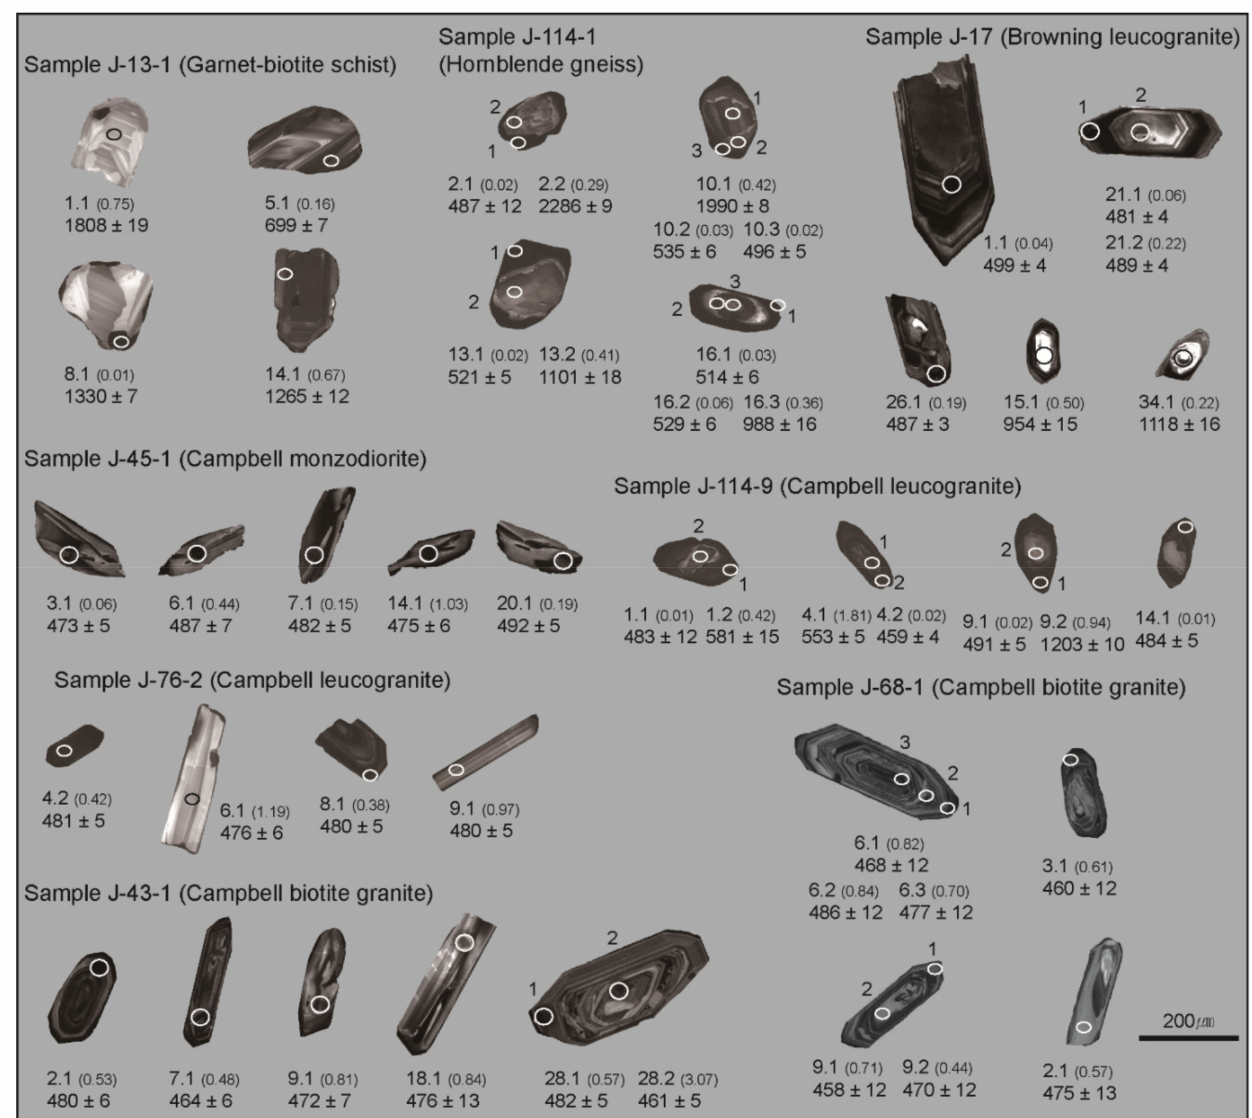
Figure 5. Representative CL images of zircons from the Wilson Metamorphic Complex and BIU–CIU. Spot numbers and apparent 206 Pb/ 238 U ages (Ma) are stated as well as Th/U ratios in